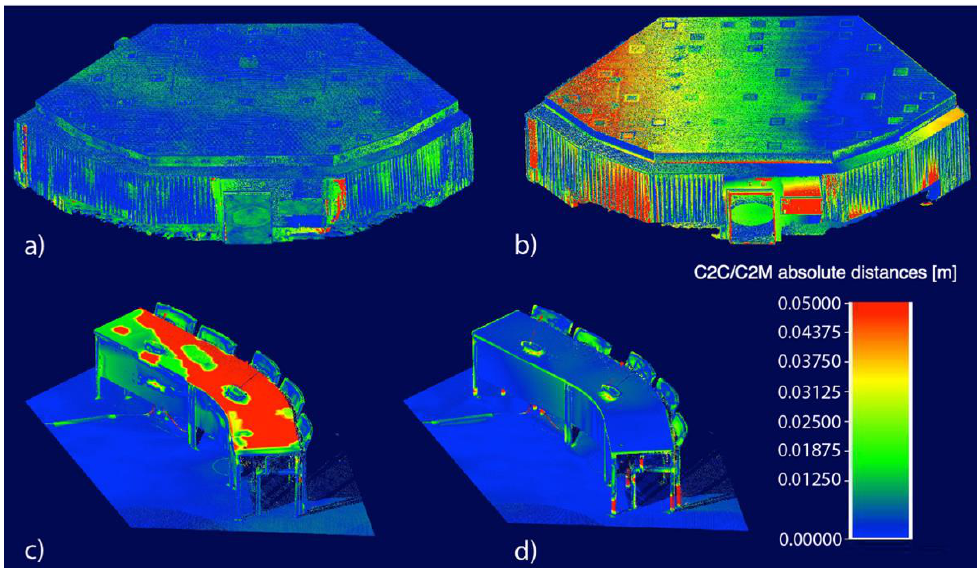
Figure 2. From the Tetra data, C2C (cloud-to-cloud)distances of the Matterport ( a ) and Theta V point clouds ( b ); C2M (cloud-to-mesh) distances of the Matterport-processed BLK360 ( c ) and Matterport ( d ) segment meshes.